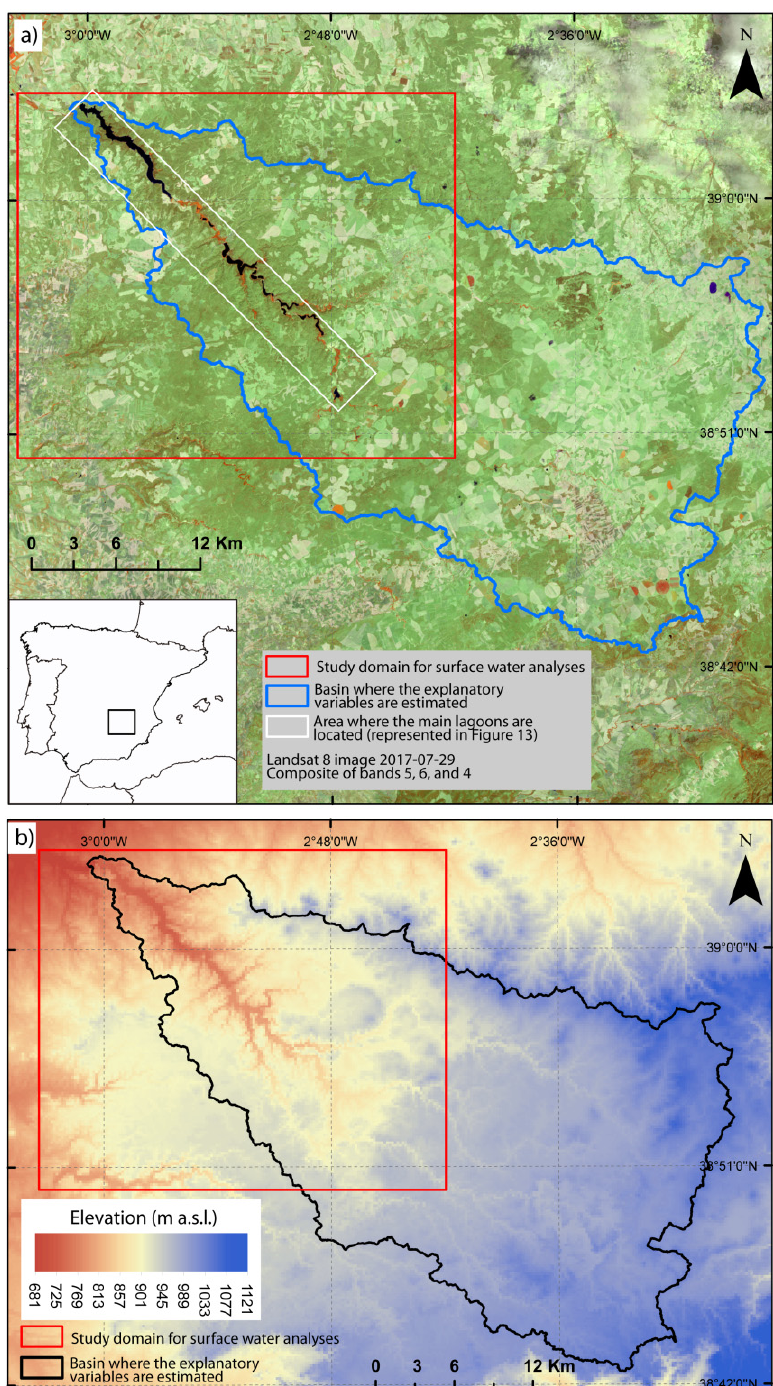
Figure 1. Study area: ( a ) location; ( b ) digital elevation model of the area.